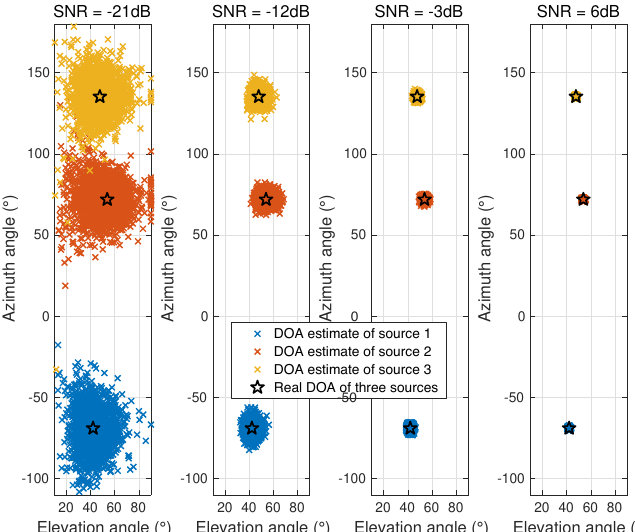
Figure 3. RMSE of 2D DOA estimation versus SNR from − 21 dB to 9 dB. ( a ) RMSE of elevation angle, ( b ) RMSE of azimuth angle.